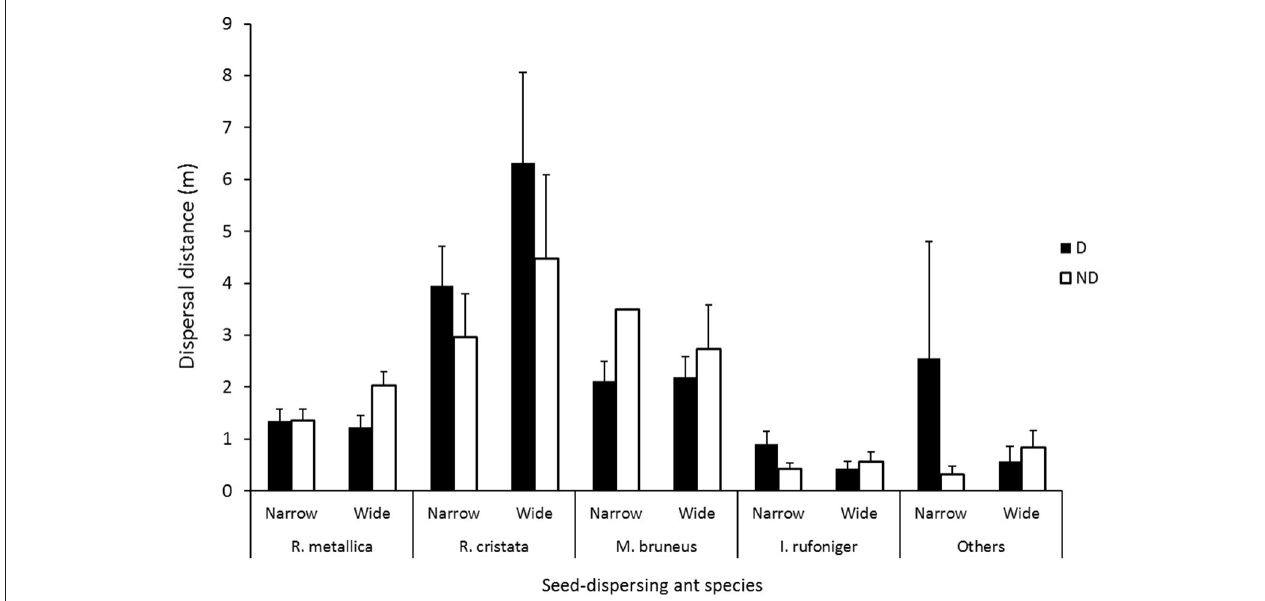
FIGURE 2 | Mean dispersal distances for individual ant species ( I. purpureus excluded) in disturbed (D; n = 669) and non-disturbed (ND; n = 677) zones in narrow and wide roadsides. Others = all other remaining species combined (see Table 1 ). Error bars represent standard error of the mean.